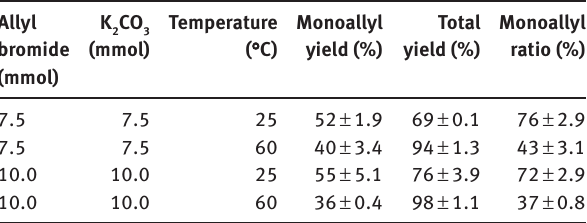
Table 1: Background experiments under conventional conditions in 24-h reaction.